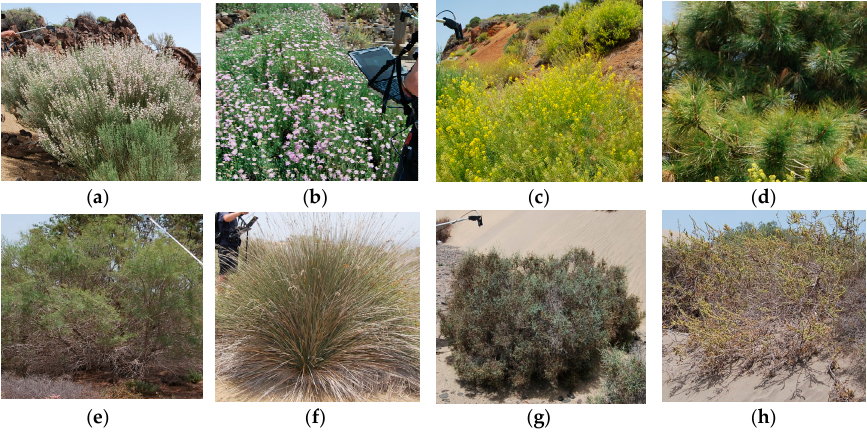
Figure 2. Vegetation measured at the Teide Park: ( a ) Spartocytisus supranubius ; ( b ) Pterophalus lasiospermus ; ( c ) Descurania bourgaeana ; ( d ) Pinus canariensis . Vegetation measured at Maspalomas: ( e ) Tamarix canariensis ; ( f ) Juncus acutus ; ( g ) Launaea arborecens ; ( h ) Traganum moquinii .